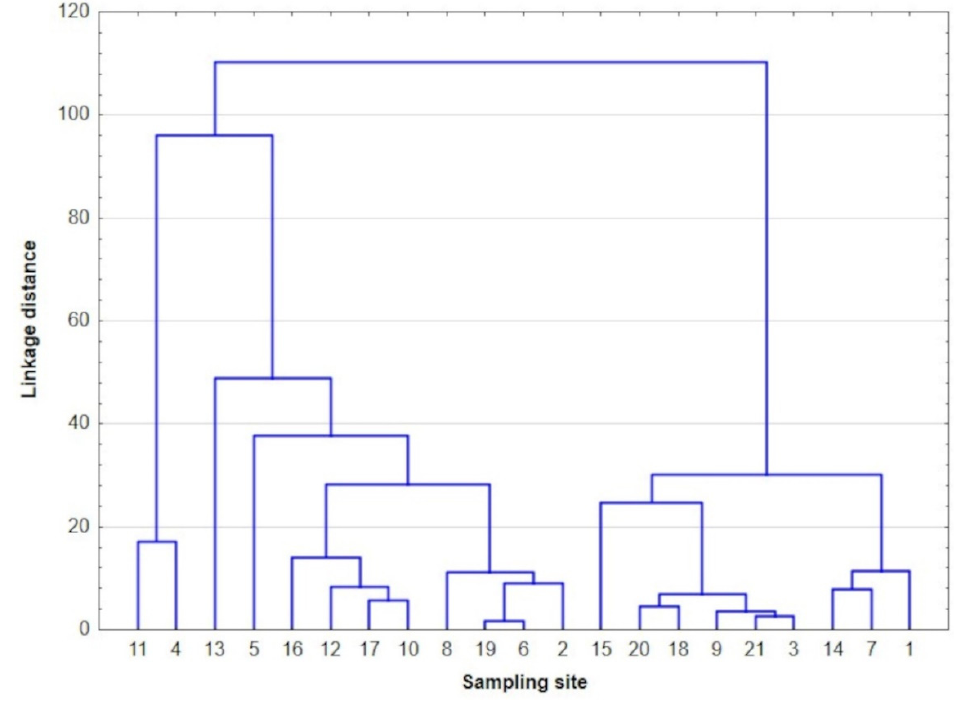
Figure 5. Dendrogram depicting clustering of sampling sites.